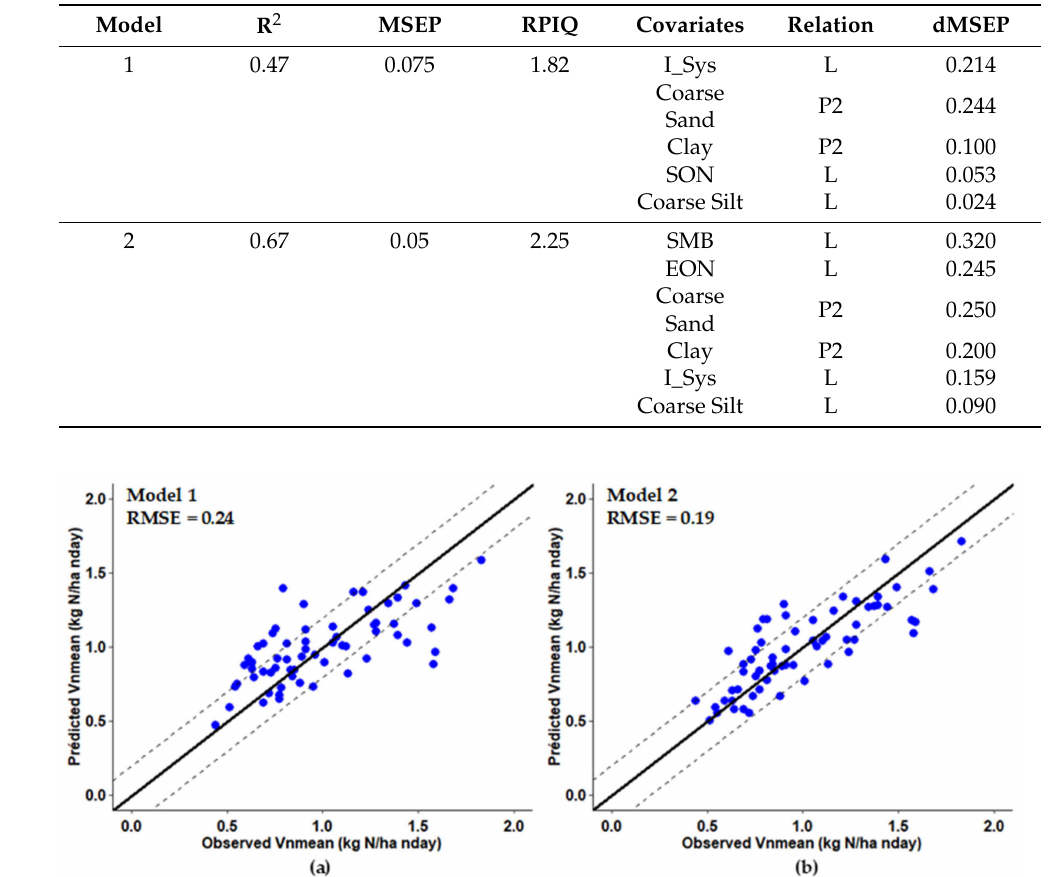
Table 4. Assessment of the models, covariates selected, and dMSEP values. Relation indicates the type of relation selected: L, linear; P2, 2nd-degree polynomial.